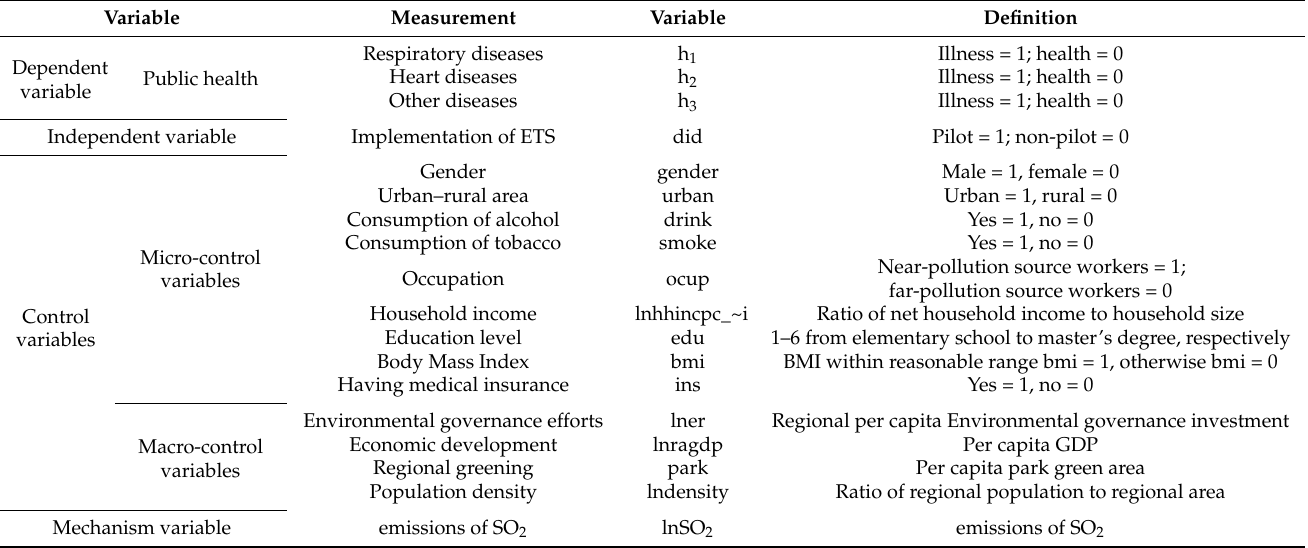
Table 1. Definition of various